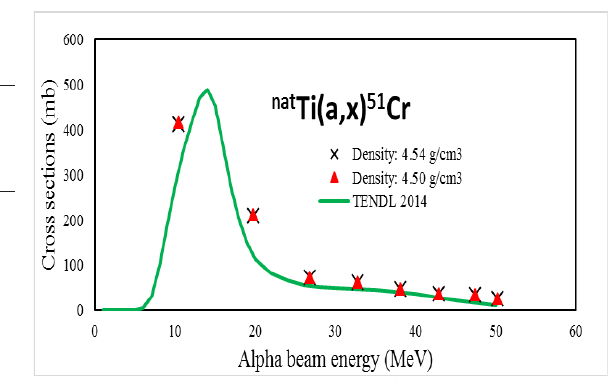
Fig. 2. Excitation function of nat Ti(α,x) 51 Cr reaction